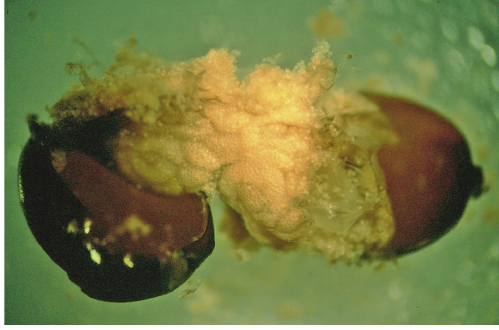
Figure 10: Mature females of Myrmeconema neotropicum packed with eggs in the gaster of a Cephalotes atratus worker in Peru.